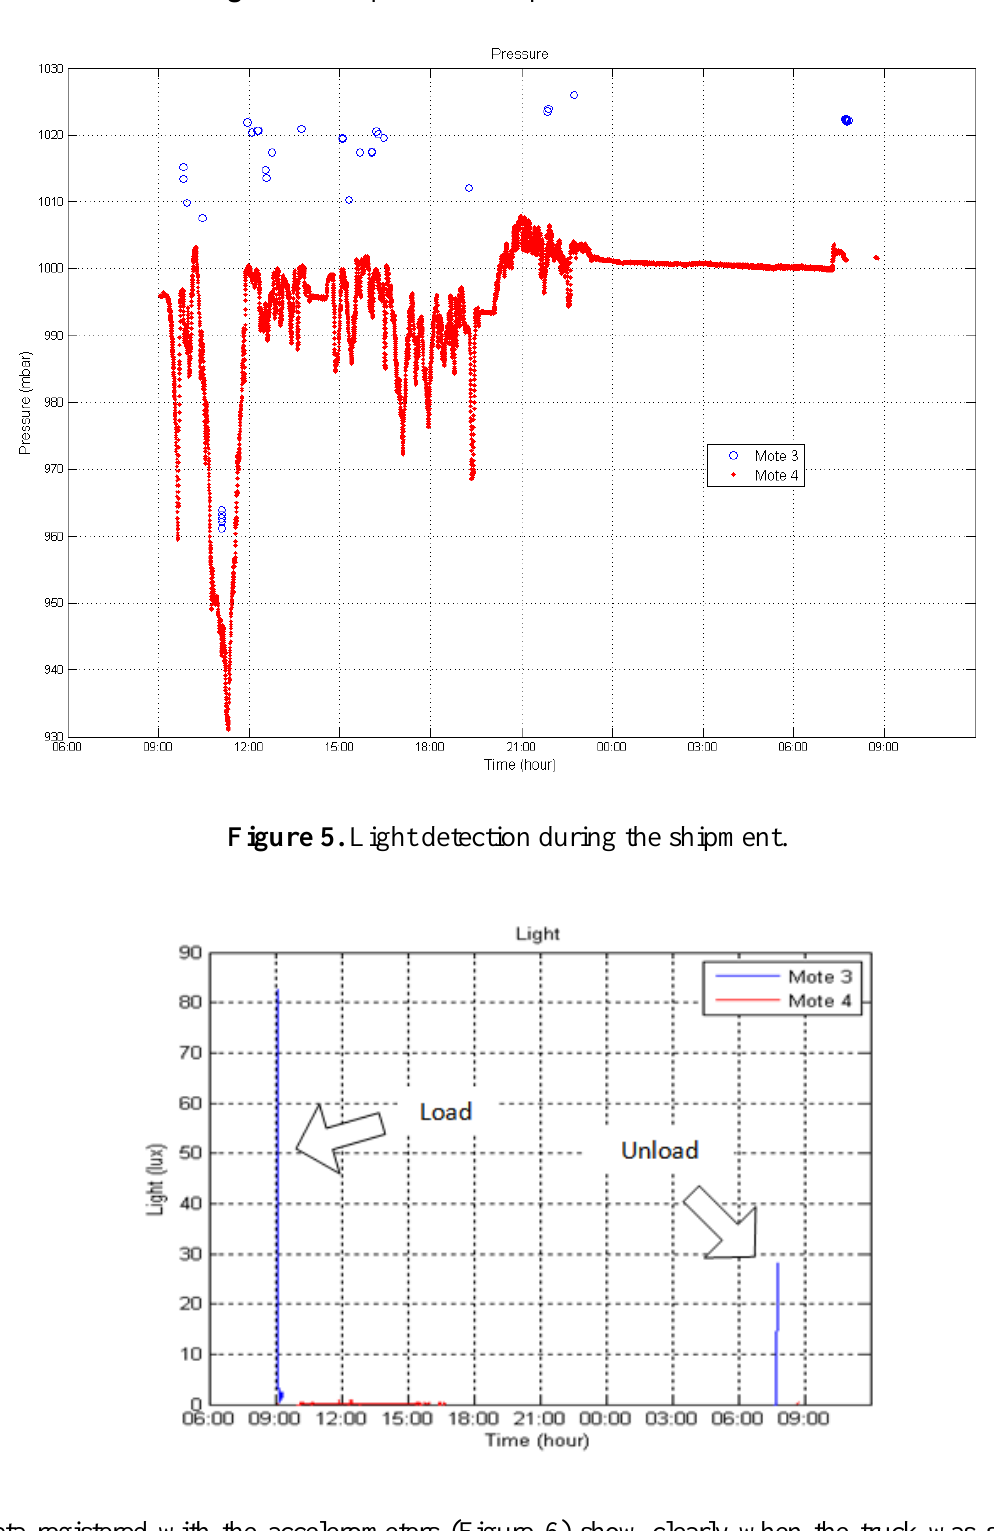
Figure 4. Air pressure comparison between motes.